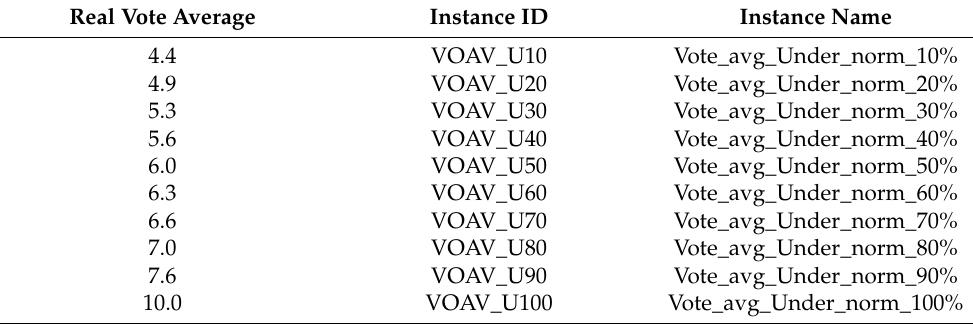
Table A6. Categorization criteria of “Vote_Average” class in the experiment.